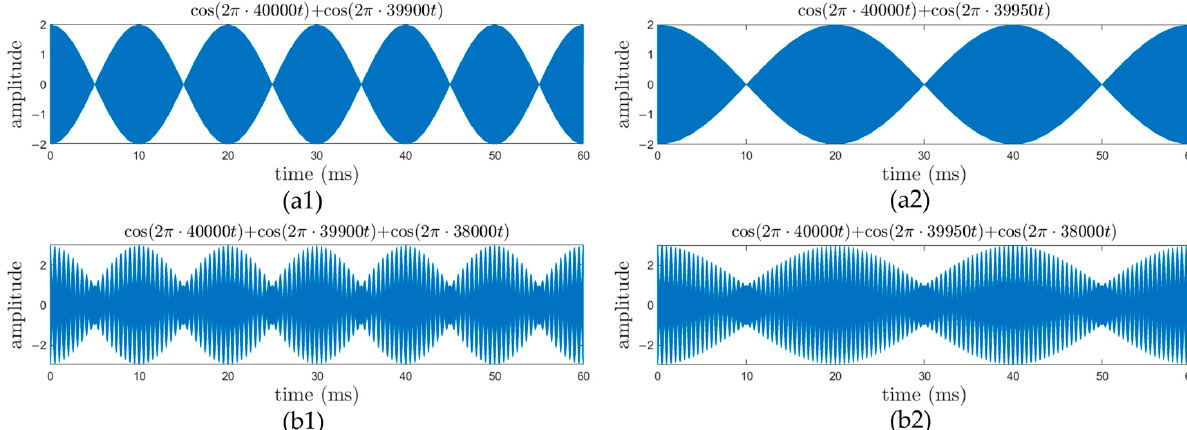
Figure 17. The illustration of TFCW waveforms ( a1 ) Before period extension and ( a2 ) After period extension, and MFCW waveforms ( b1 ) Before period extension and ( b2 ) After period extension.